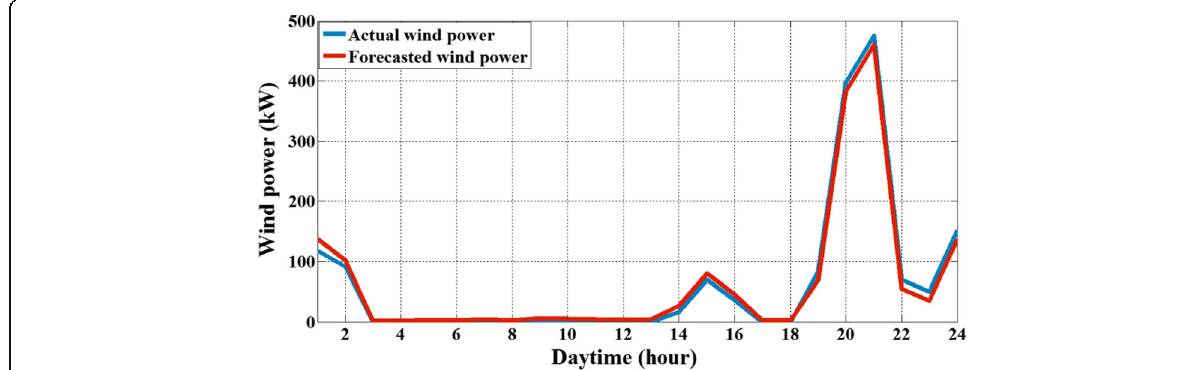
Fig. 6 Actual wind power vs. forecasted wind power for a summer day